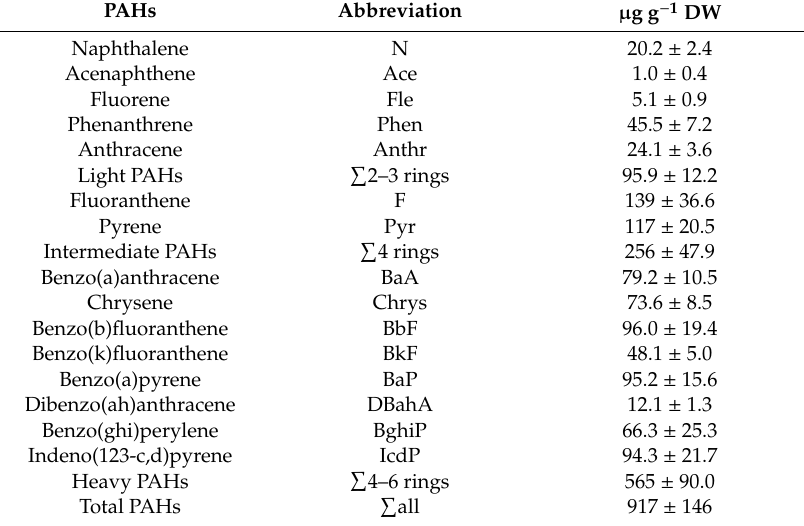
Table 1. Experimental soil polycyclic aromatic hydrocarbons’ (PAHs) initial